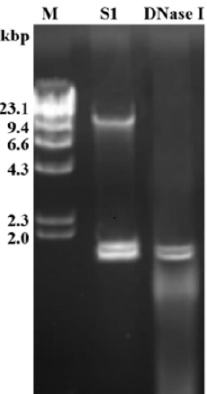
Figure 1. Electrophoresis analysis of enzyme-treated nucleic acid samples on 1% agarose gel. The nucleic acid samples were treated with S1 nuclease and DNase I, respectively. M: molecular markers ( λ DNA digested with Hind III); Kbp: kilobase pair; gDNA: genomic DNA of the fungal strain D122.